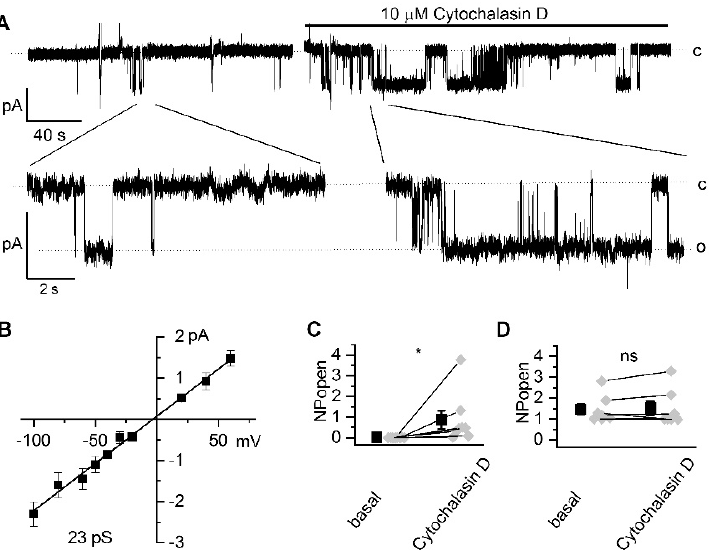
Figure 3. Application of cytochalasin D to podocytes from freshly isolated glomeruli induces TRPC6 channel activation. ( A ) Representative example of basal channel activity before and after 10 µM cytochalasin D application at –40 mV holding potential. Expanded fragments are shown below. Open and closed channel states are indicated with (o) and (c), respectively. ( B ) Current-voltage relationship of recorded channels. ( C ) Summary graph of the endogenous silent TRPC6 activity induced by 10 µM cytochalasin D in podocytes. ( D ) Summary graph demonstrating the effect of the application of 10 µM cytochalasin D on constitutive endogenous TRPC6-like channel activity (NP o ) in freshly isolated glomeruli. Wilcoxon nonparametric test for paired samples; * = p < 0.05.